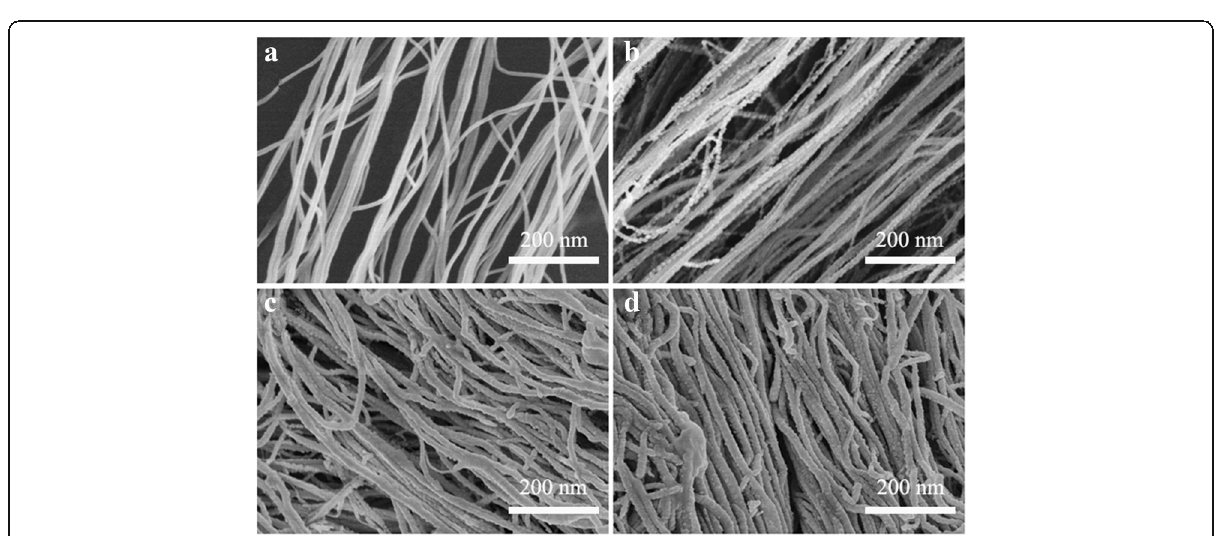
Fig. 2 High-resolution SEM images of a bare CNT, b Au 5 @CNT, c Au 15 @CNT, and d Au 20